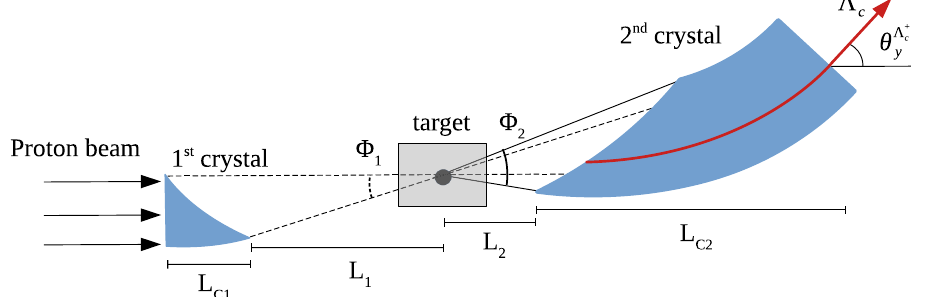
that of the first crystal plus the maximum opening angle of the (cid:2) + c , (cid:7) ≈ (cid:7) + 2 (cid:7) θ C 2 is experienced (cid:2) + c . The maximum deflection angle 2 1 , below by the (cid:2) + c particles that are produced with an aperture − (cid:7) (cid:2) + c the horizontal. After being fully deflected by an angle + θ C 2 , these exit (cid:2) + c y the crystal lens at an angle θ